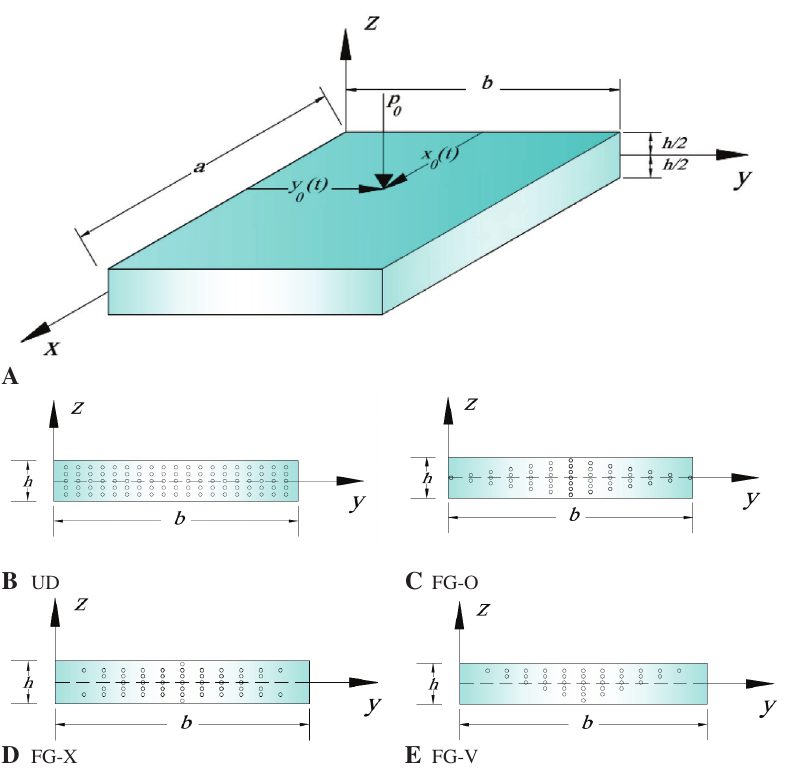
Figure 1 (A–E) Geometry and loading of CNTRC plate with different CNT